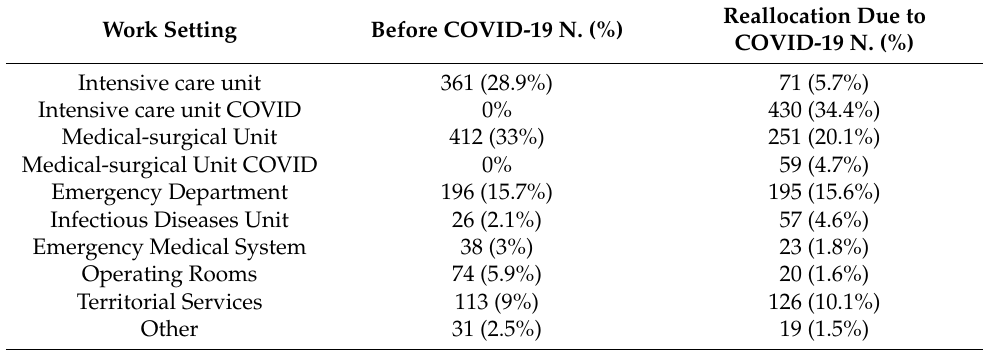
Table 1. Reallocation of nurses included in the study due to the COVID-19